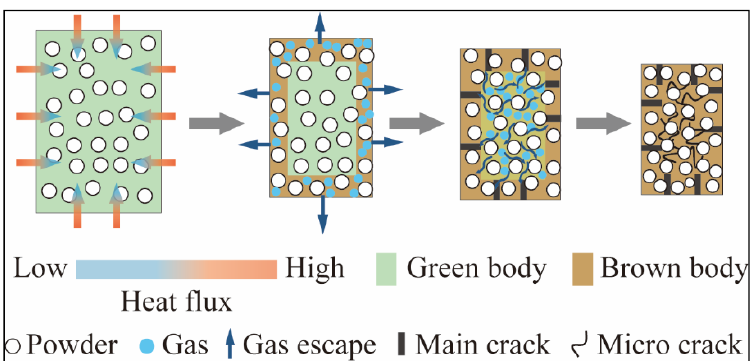
Figure 12. The SEM images of three-point vertical loading. ( a ): Schematic diagram of the experiment; ( b – d ): Fracture morphology and partially enlarged views.